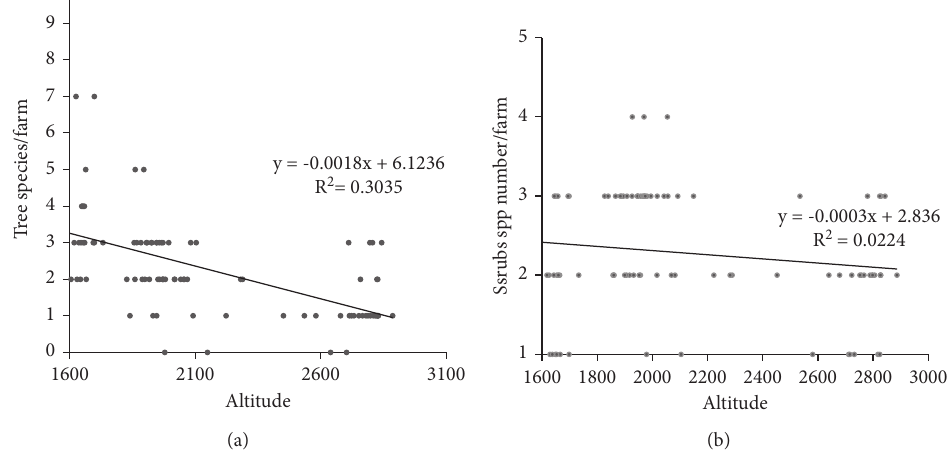
Figure 3: The altitude gradient against to tree species richness (a) and shrub species richness